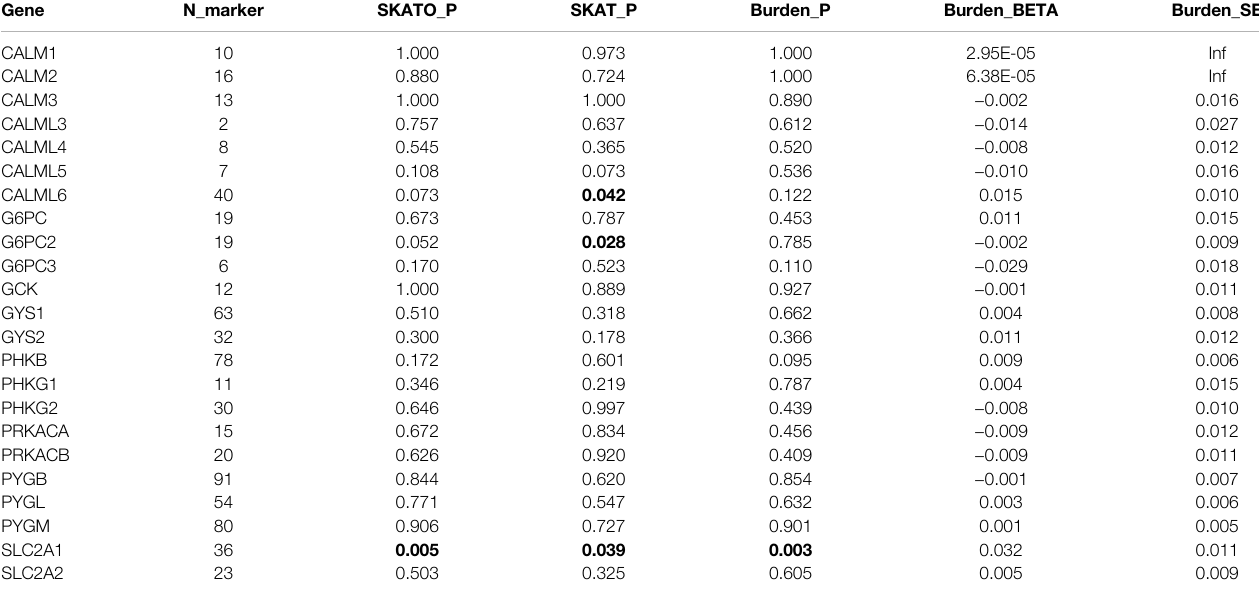
TABLE 4 | Burden test of rare SNPs in glycogen metabolism pathway.